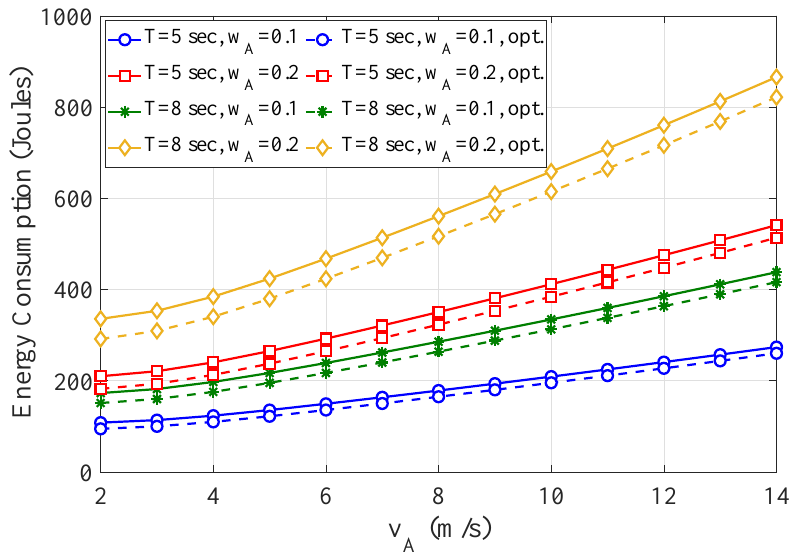
Figure 9. The non-optimized and optimized WTEC as a function of the velocity of ARSU for different task completion time and weight factor of energy consumption of